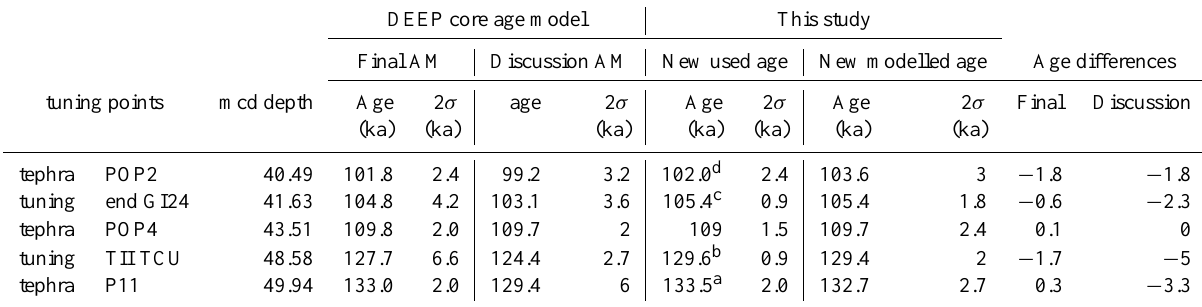
Table 1. Chronological tie points discussed in this study. DEEP core ages and associated 2 σ uncertainties are from Francke et al. (2015, Discussion AM) and Francke et al. (2016, Final AM) age